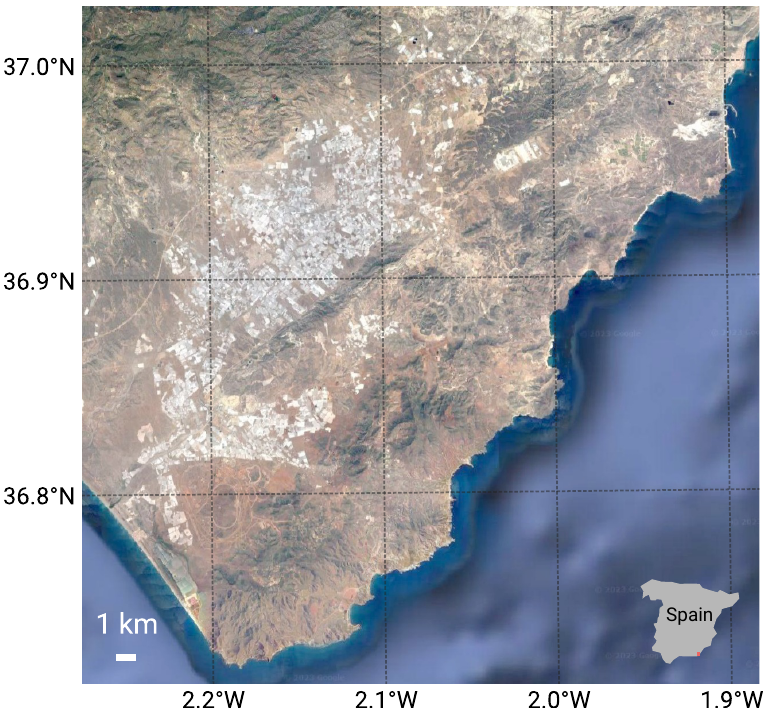
Figure 6. True-color image of Almería, southeast Spain. White objects are primarily greenhouses. Im- agery © 2023 Google, TerraMetrics, Data SIO, NOAA, U.S. Navy, NGA, GEBCO, Landsat/Copernicus, and map data © 2023 Instituto Geográfico